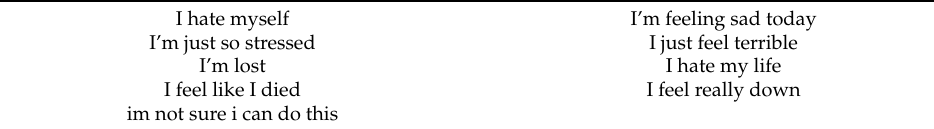
Table 1. Opening